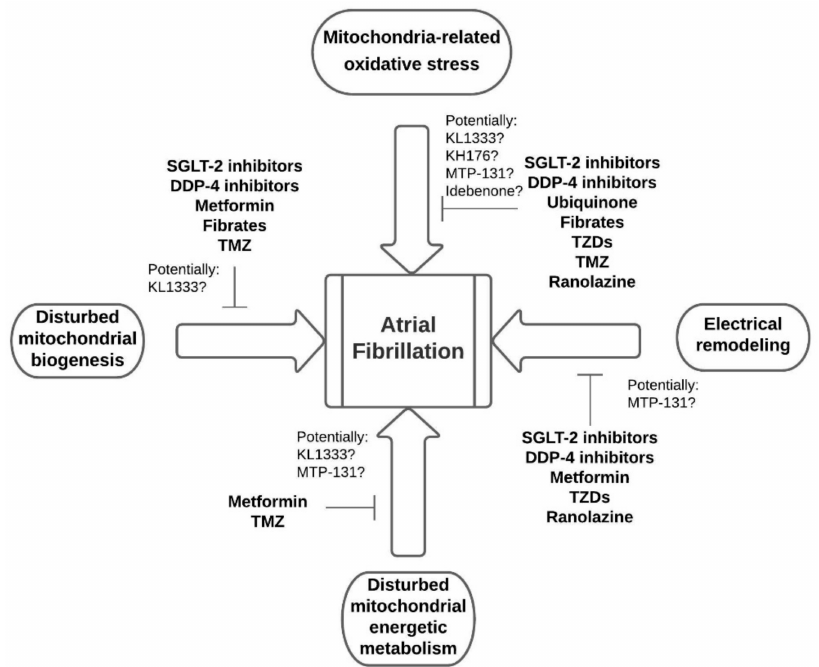
Figure 2. Pharmacological interventions targeting basic mechanisms of atrial fibrillation. Ab- breviations: SGLT2—sodium-glucose co-transporter 2, DDP-4—dipeptidyl peptidase-4, TZDs— thiazolidinediones,